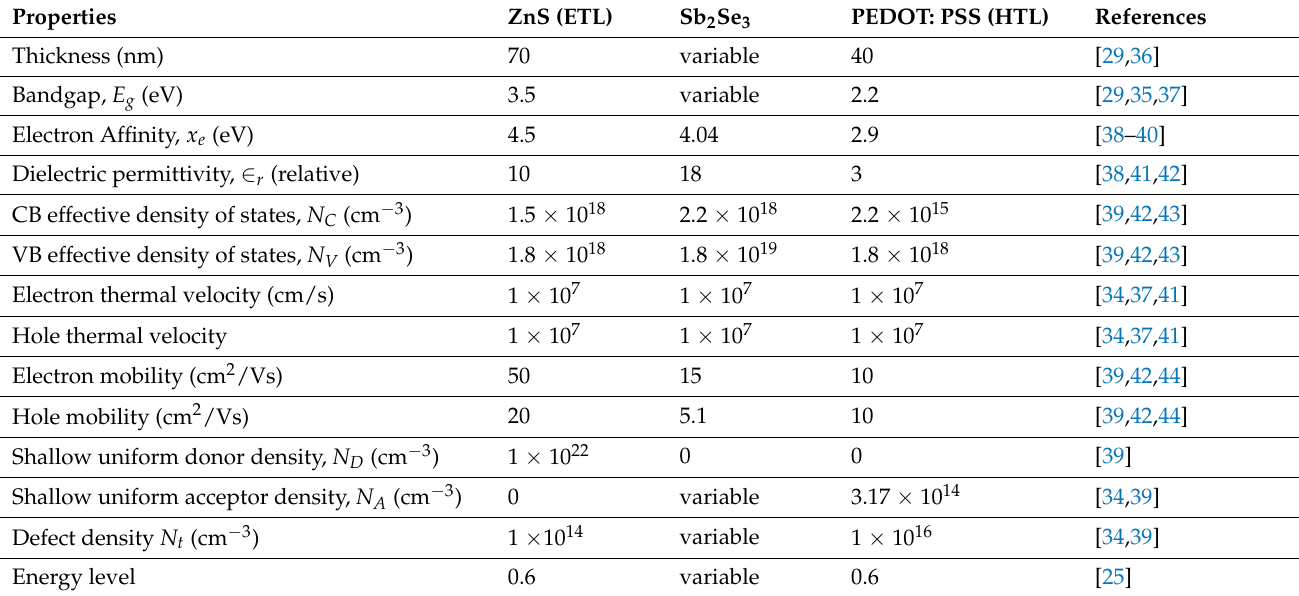
Table 1. List of various simulation parameters involved in the perovskite planar